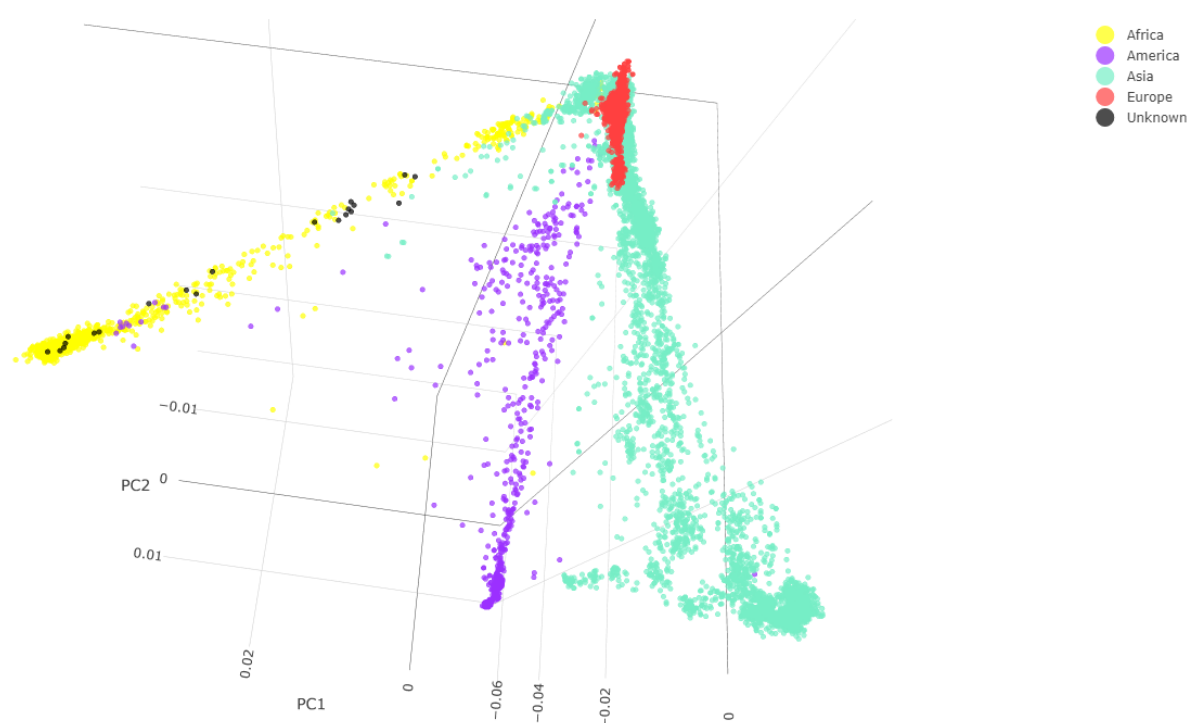
Figure 2. Individuals from the database belonging to the different continents are represented with different colors. Unknown individuals are in black. Score plots PC1, PC2, and PC3.